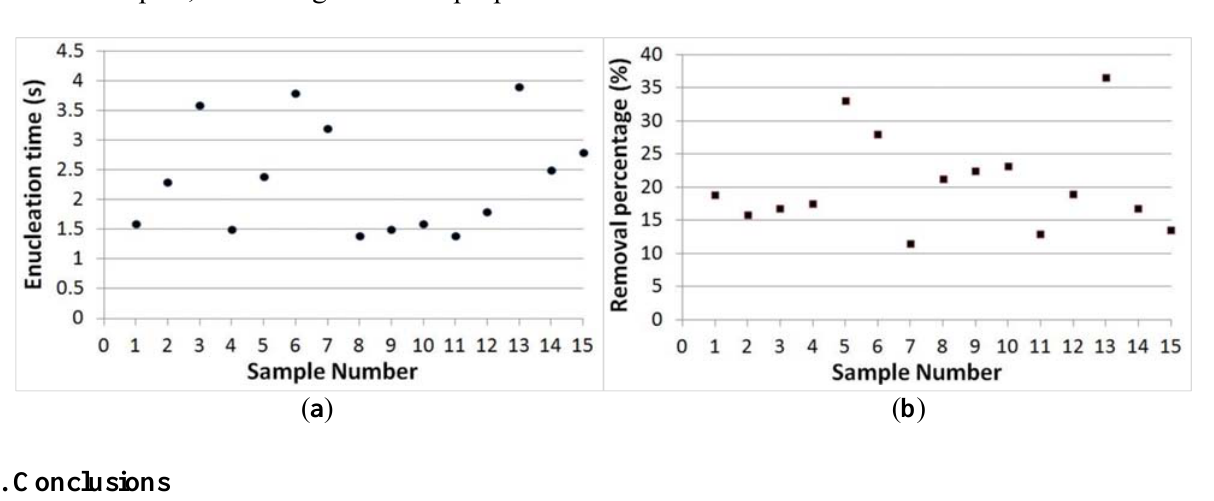
Figure 9. ( a ) Enucleation processing time for 15 samples; the average enucleation time is 2.5 s for one oocyte. ( b ) Removal proportion of the nucleus from the original oocyte for 15 samples; the average removal proportion is